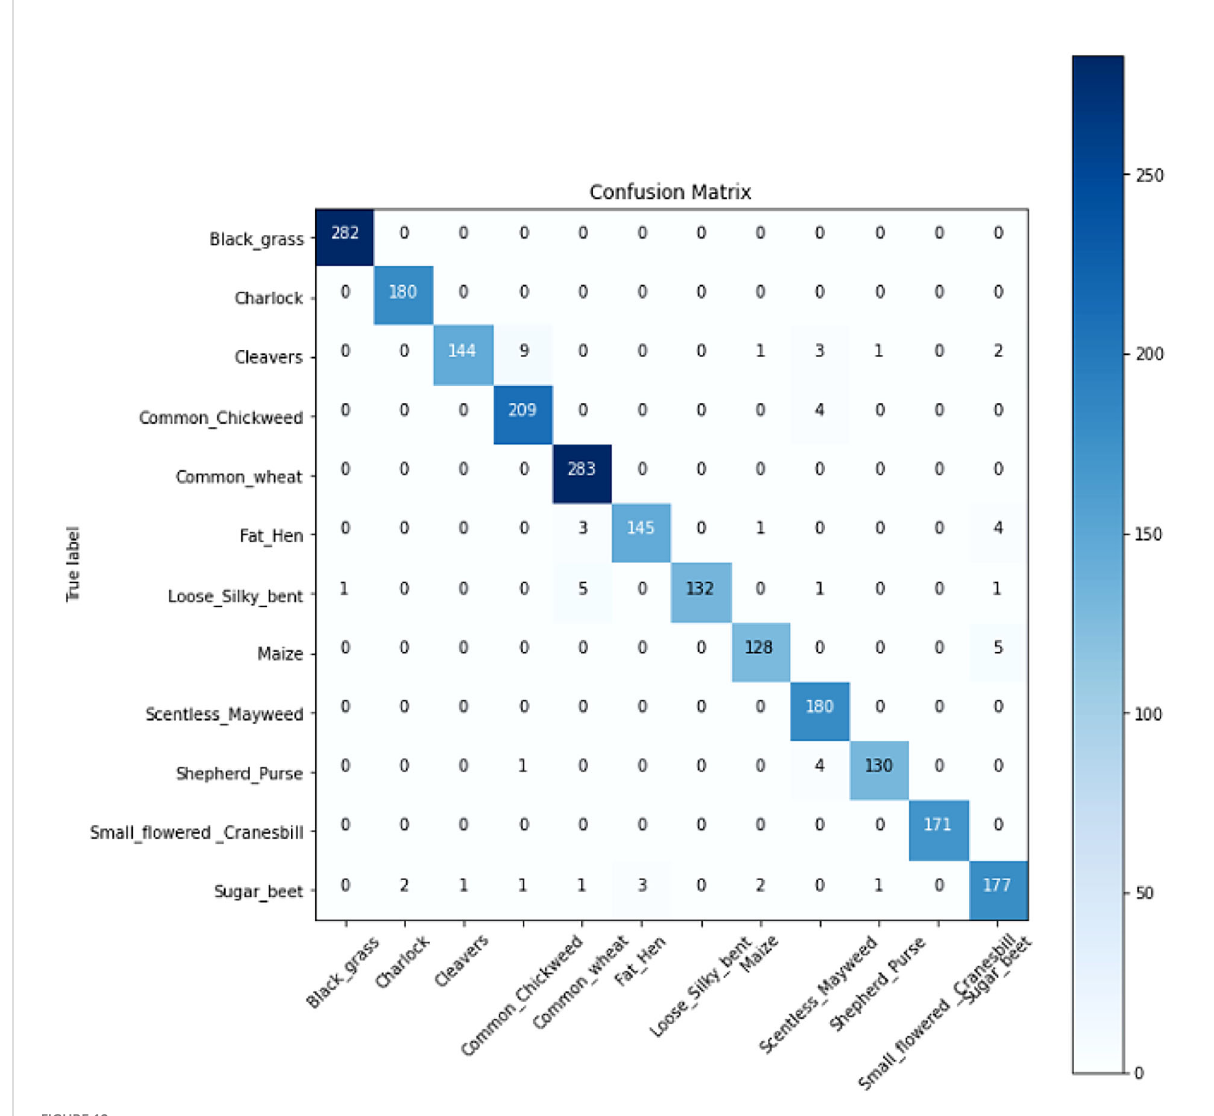
FIGURE 12 The confusion matrix of our